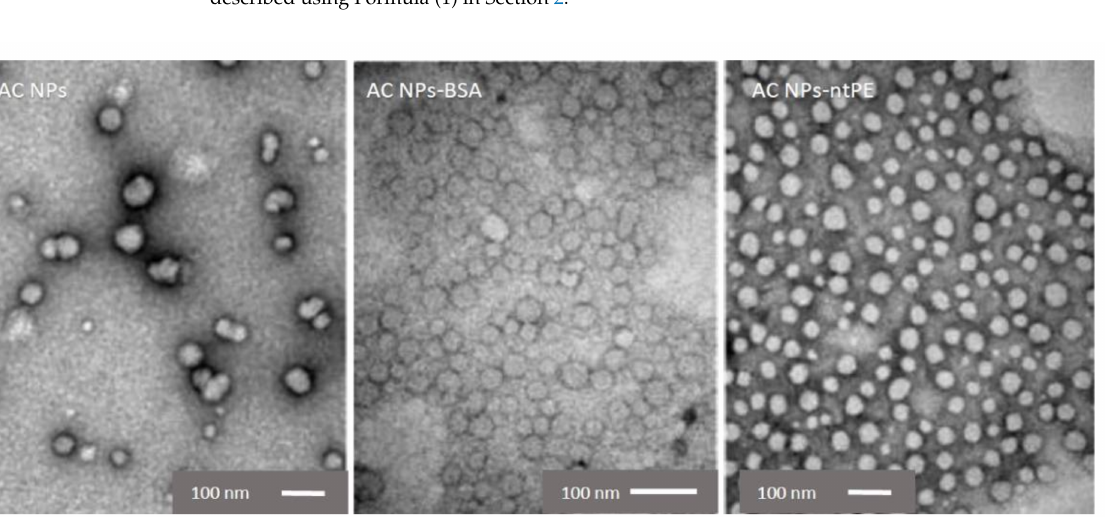
Figure 4. Structural examination of NPs. Transmission electron microscopy images of alginate/chitosan condensate nanoparticles (AC NPs) before and after chemical coupling with bovine serum albumin (AC NPs-BSA) or non-toxic Pseudomonas aeruginosa exotoxin A (AC NPs-ntPE), demonstrated by negative staining. Scale bar = 100